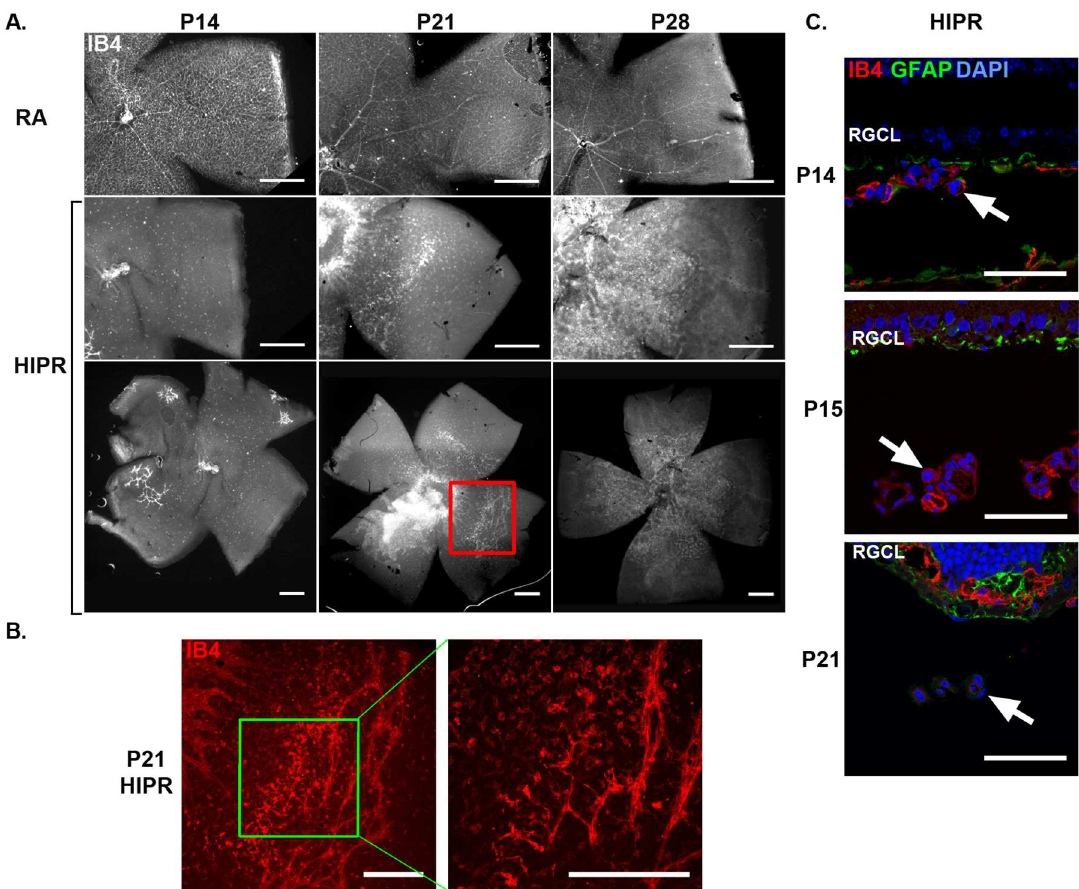
Fig 1. Disorganized angiogenesis in hyperoxia-induced proliferative retinopathy. (A) Representative flat mounts from P14, P21, and P28 mice in control mice (RA) and HIPR were stainedwith IB4 (N = 3–4). Scale bar, 500 μ m. (B) Left image is an inset of the red box of P21 HIPR in (A). Right image is an inset of the green box. Persistent hyaloidalvasculature is present and attached to the retina in the mid-periphery. Scale bar, 300 μ m. (C) Retinalcross sections stainedwith IB4 (red), GFAP (green), and DAPI (blue) of HIPR retinas show a persistent hyaloidalvessel (arrow) close to the retinal surface (N = 3–4). Scale bar, 50 μ m. RGCL, retinal ganglioncell